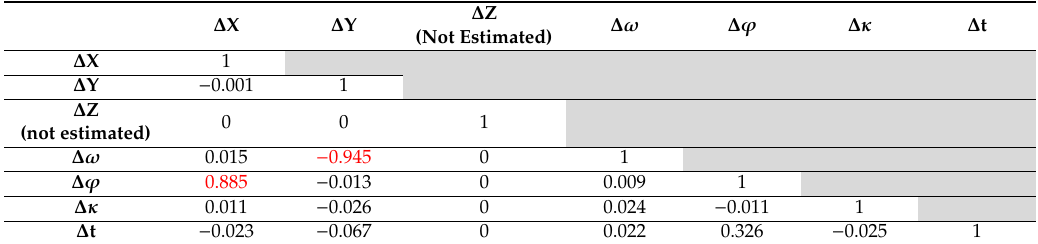
Table 6. Correlation matrix of system parameters for July 25th thermal direct approach